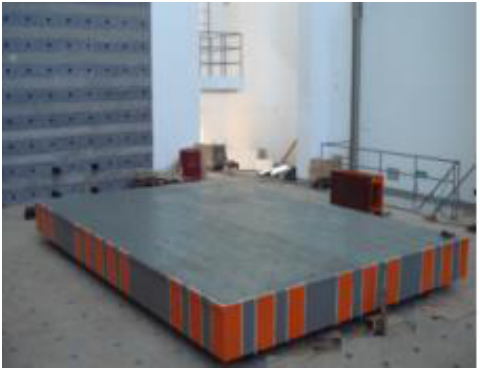
Figure 10. Installed specimen. ( a ) Placing mass block; ( b ) hoisting at the appropriate